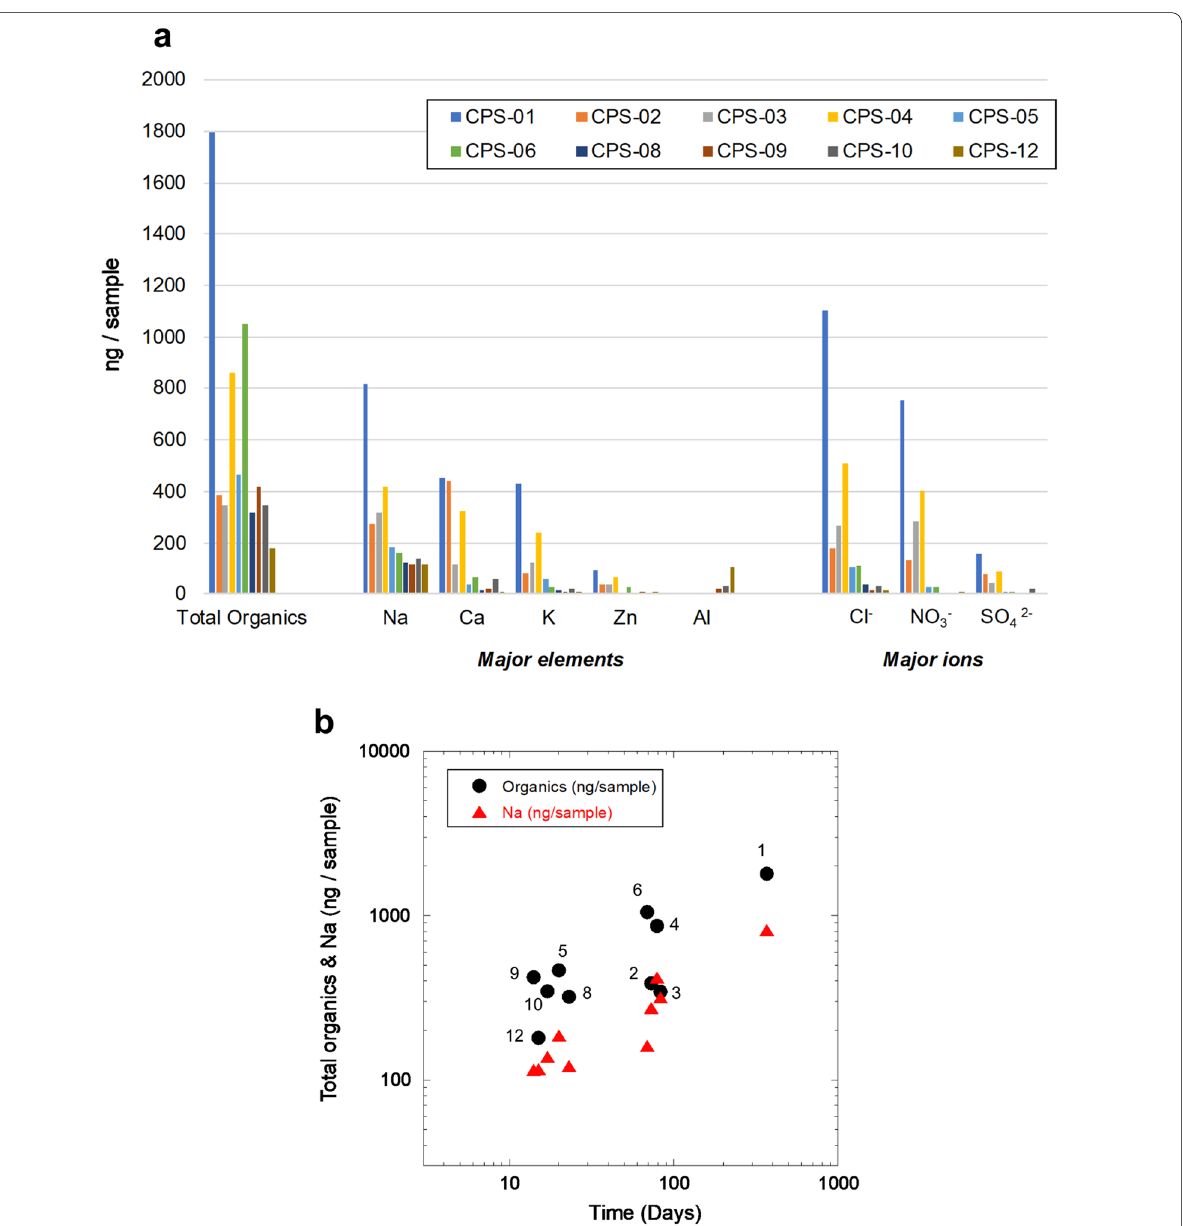
Fig. 4 a Concentrations of total organics, major elements, and major ions monitored by the monitor coupon (Nos. 1–12, including STA1, SFA2, and VAB). The sample codes were listed in Tables 2 and 3. Each static, quantitative assessment was normalized in units of nanograms per sample (ng/ sample). b Quantitative comparison between static monitoring and unit time (days) with regard to total organics and Na